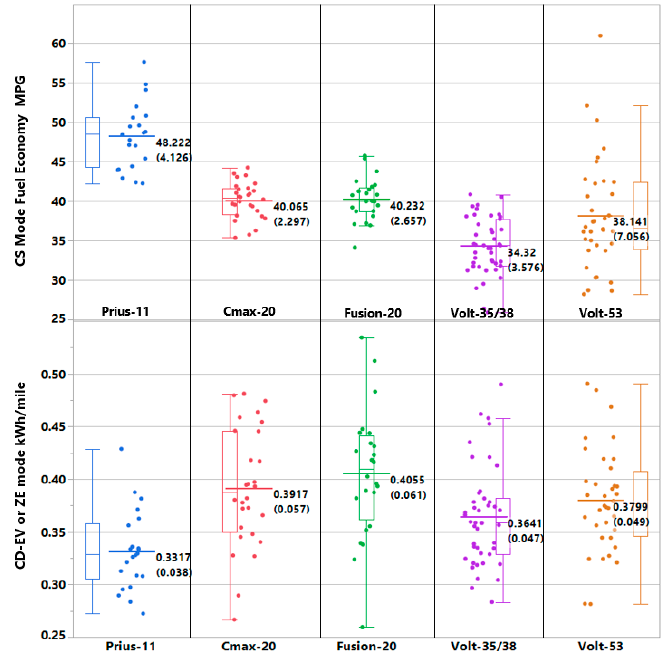
Figure 6. Distribution of real-world fuel economy (MPG) in CS mode trips and electricity consumption in CD-EV or ZE mode (kWh/mile) trips. In the ZE mode the engine was never turned on and CS trips was accomplished entirely on gasoline. Values adjacent to the solid dashed line show the average and standard deviation.